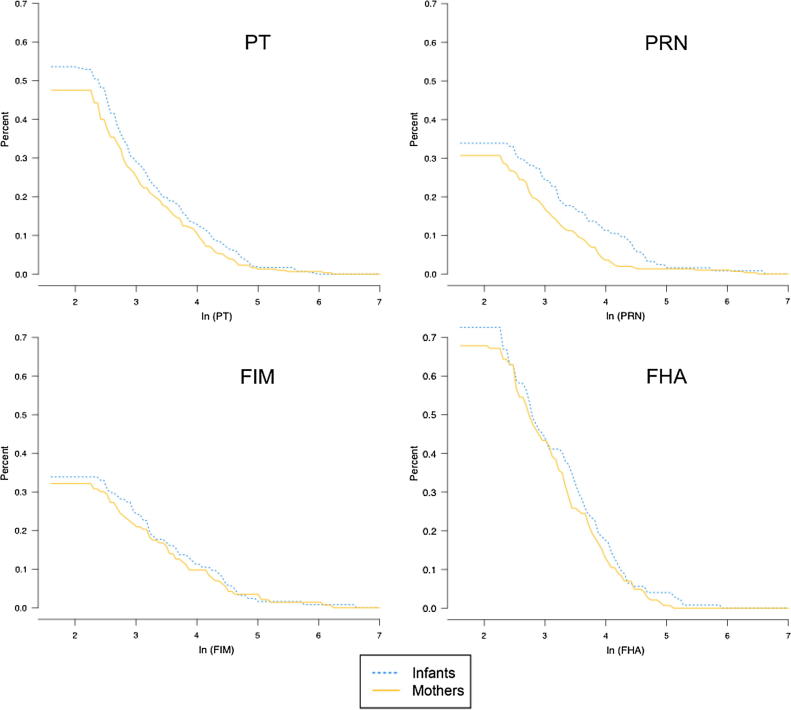
Reverse cumulative distribution curves of four pertussis antibodies for mothers and infants.